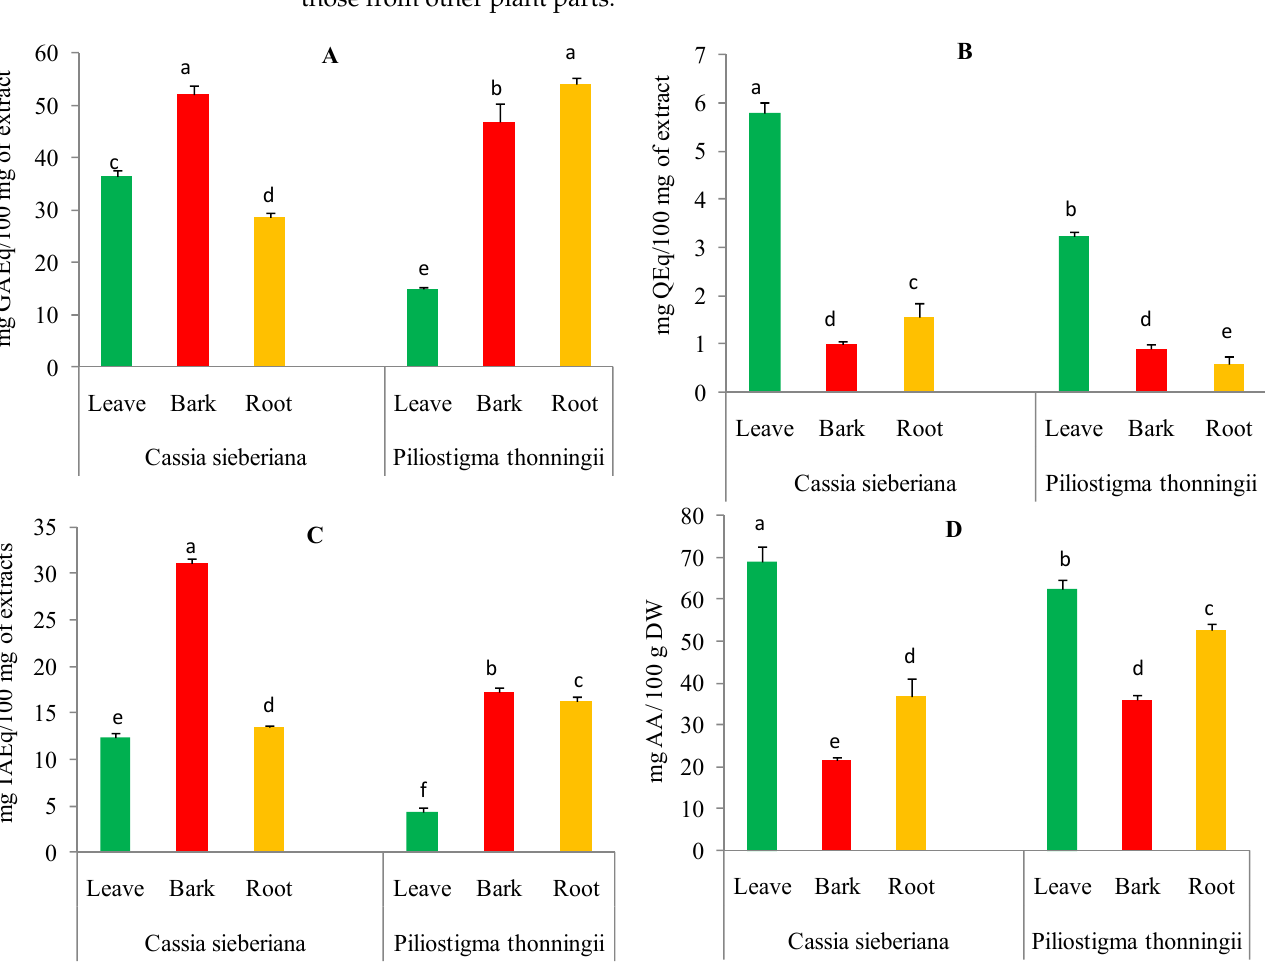
Figure 1. Content of polyphenols ( A ), flavonoids ( B ), condensed tannins ( C ), and vitamin C ( D ) in aqueous extracts of C. sieberiana and P. thonningii organs. Error bars represent ± standard deviation (SD) of three replicates. Means that do not share the same letter (a, b, c, d, e, f) in the same graph are significantly different by Tukey’s tests ( p < 0.05).